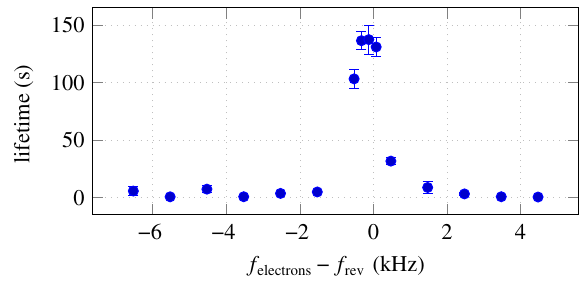
FIG. 12. Dependence of the ion beam lifetime on the frequency mismatch between ion and electron pulses. The error bars result from averaging over multiple runs.